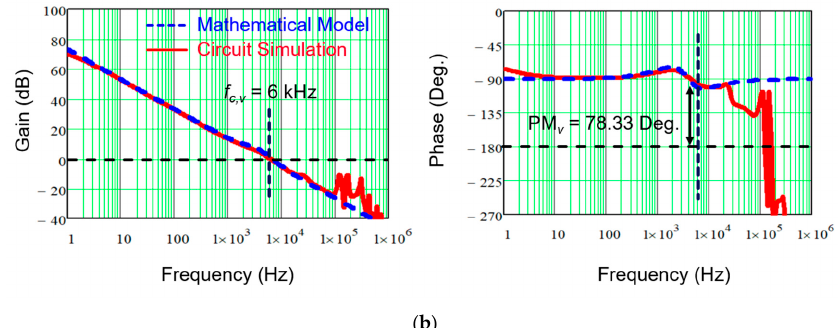
Figure 16. Bode plot of the output-voltage loop gain ( a ) uncompensated and ( b ) compensated.